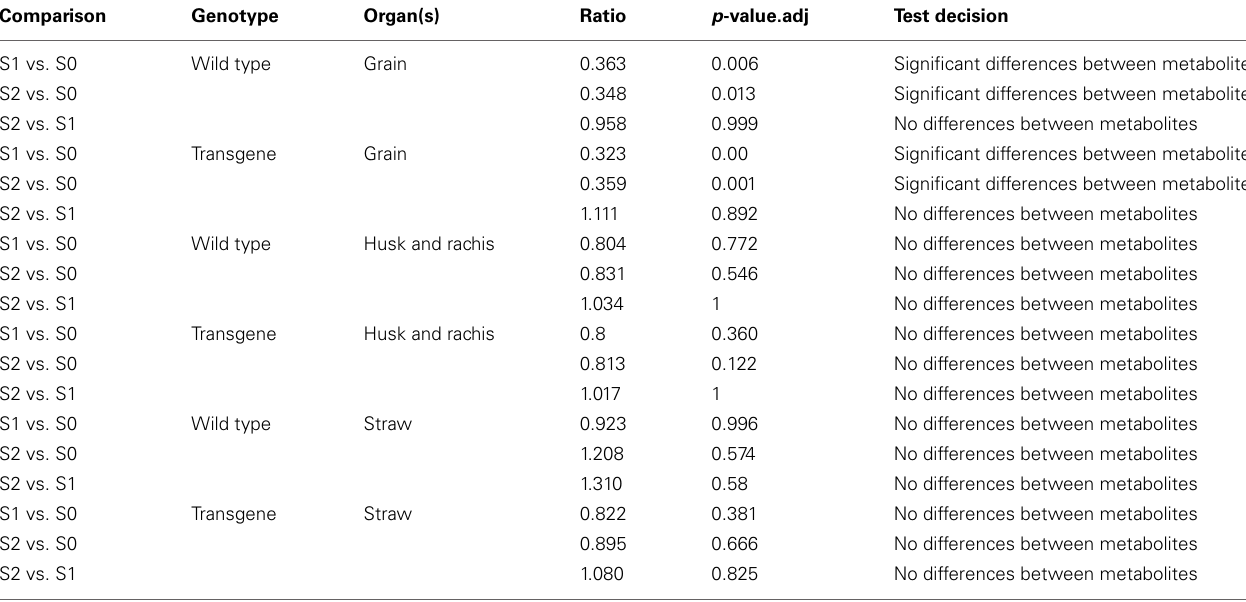
Table 2A | Testing the influence of variable sulfur fertilization rates on the metabolite profile i.e., metabolome. Comparison